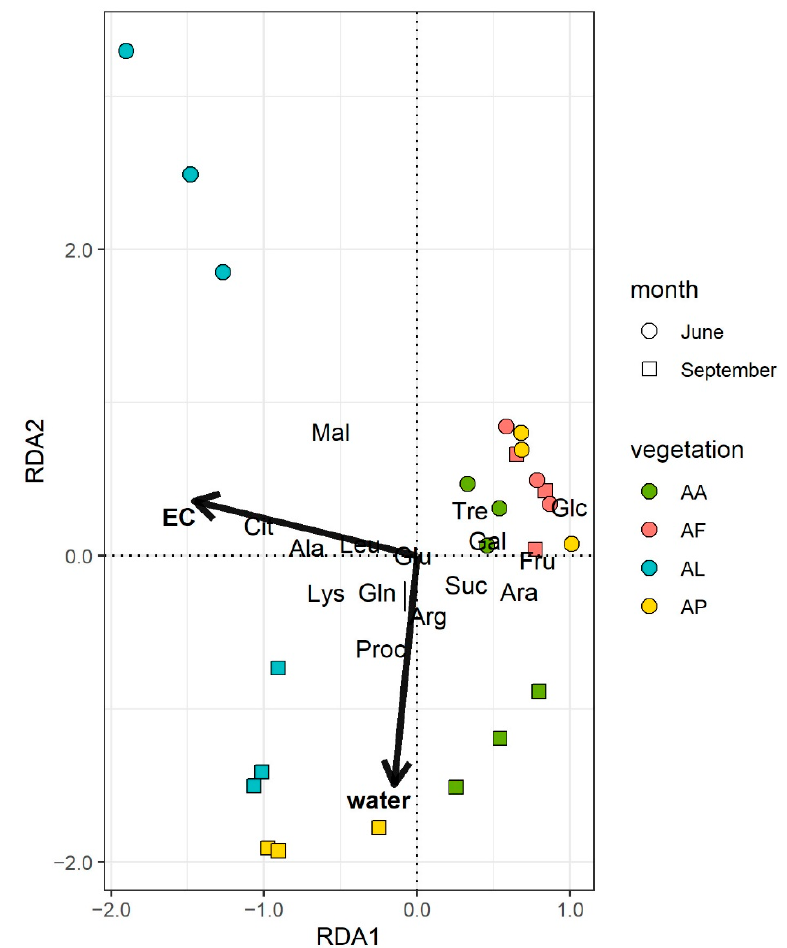
Figure 2. Redundancy analysis plot of the final model for the catabolic profiles. The lengths of arrows for environmental variables were multiplied by 1.5 for better visibility. (EC: electrical conductivity ( µ S cm − 1 ), water: soil water content ( m/m %). Sample identifiers are presented in Table 1). The meaning of the abbreviated substrate names are in the Materials and Methods in Section 2.4 .